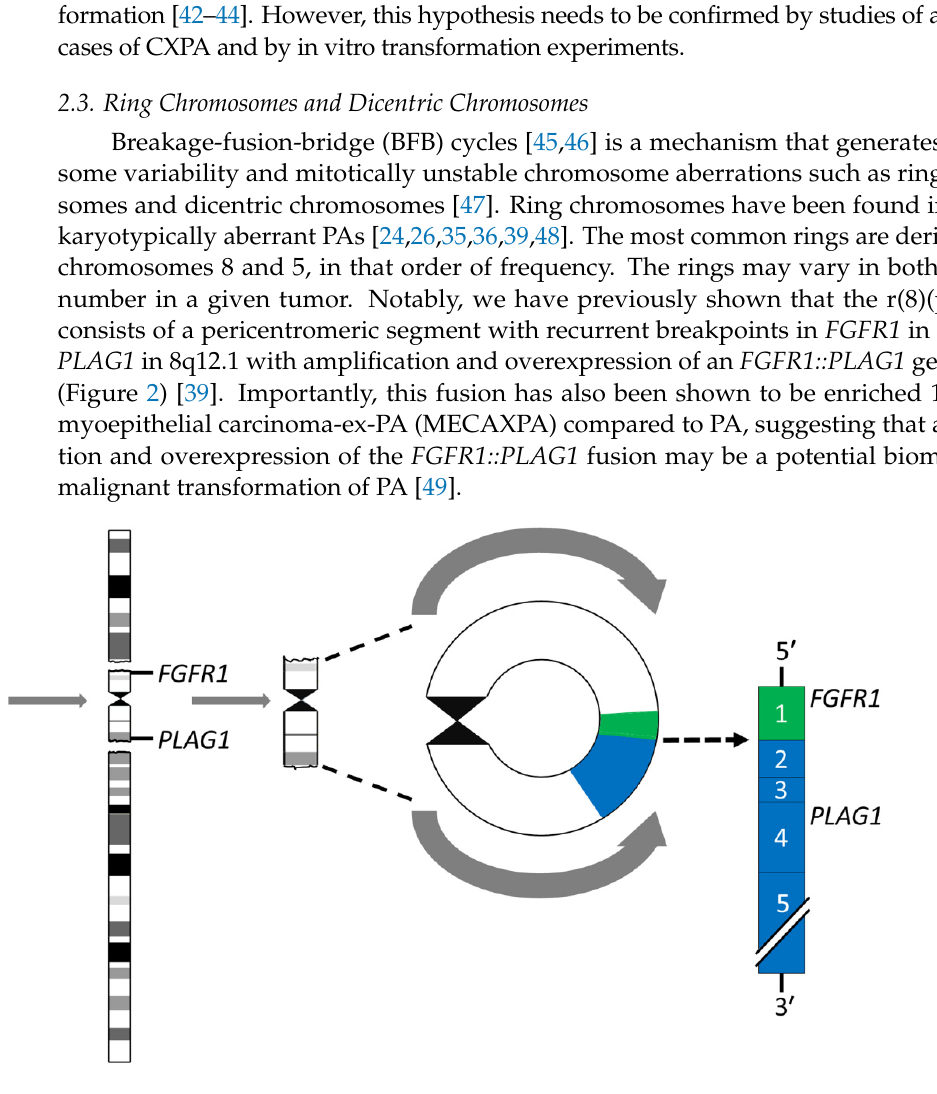
Figure 2. Ring chromosome 8 in PA . Schematic illustration of the formation of the ring chromosome r(8)(p12q12.1) and the resulting FGR1::PLAG1 gene fusion in which exon 1 of FGR1 (green) is fused to exon 2 of PLAG1 (blue).